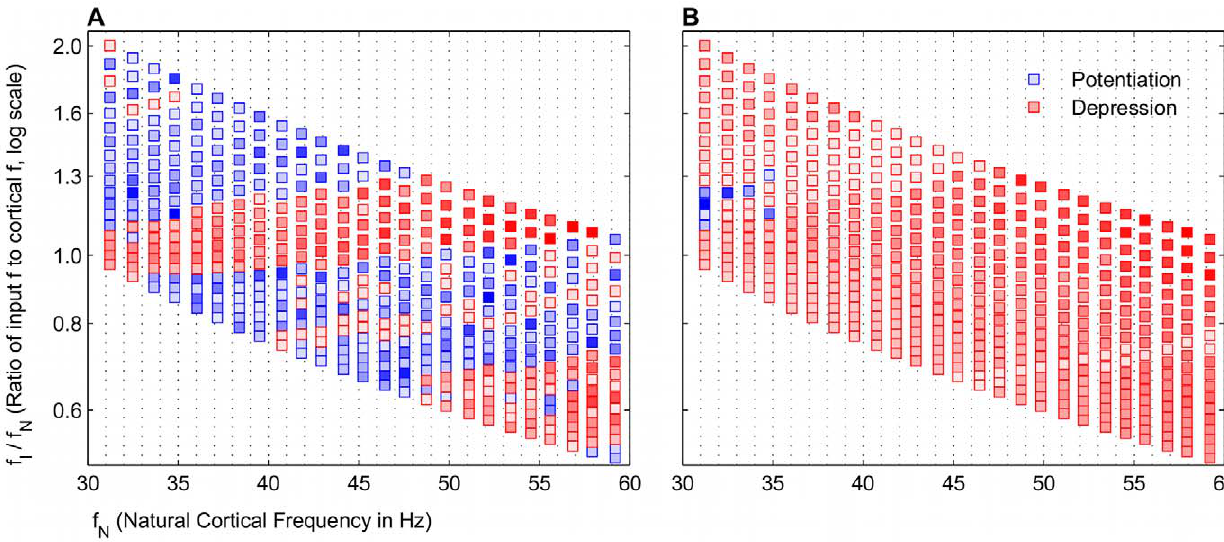
Figure 14. Frequency maps for A -- wwww A zzzzzzz result in nearly complete depression. Conductances are averaged around window w ~ 100 ms to calculate potentiation and depression. In both subfigures, t z ~ 14 ms and t { ~ 34 ms . (A) Standard broad bands of potentiation existed when the amplitude for potentiation is greater than depression. A z ~ 5 : 0x10 { 3 , A { ~ 2 : 5x10 { 3 . (B) 442/450 frequency regimes depressed when the amplitude for depression was greater than potentiation. A z ~ 5 : 0x10 { 3 and A { ~ 1 : 05 : A z